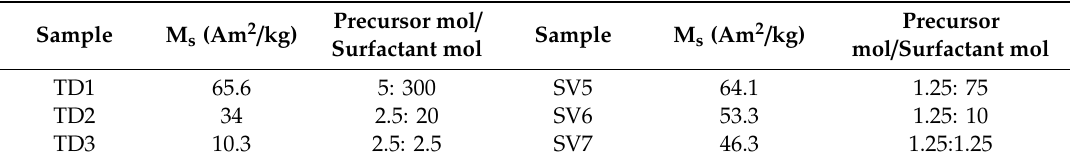
Table 6. Comparison of saturation magnetization values of TD1-SV5, TD2-SV6, and TD3-SV7 pairs. These values are not justified for the metallic core mass. The molar ratio between the precursor and the surfactant remained constant in any samples’